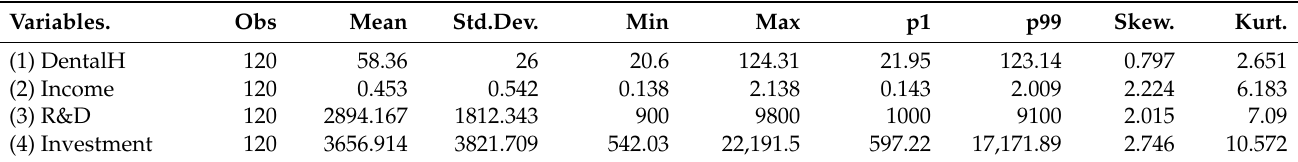
Table 3. Descriptive